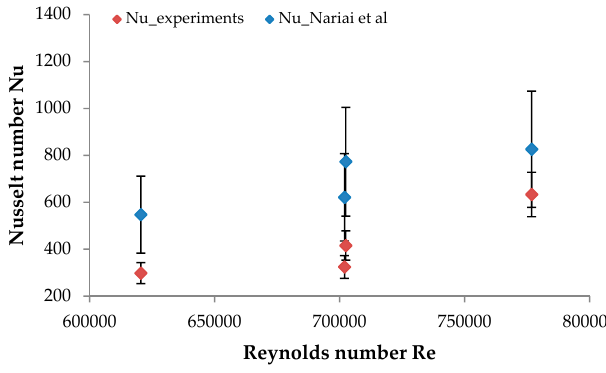
Figure 7. Comparison of the experimental Nu number with the heat transfer correlation from literature obtained at subcritical conditions.